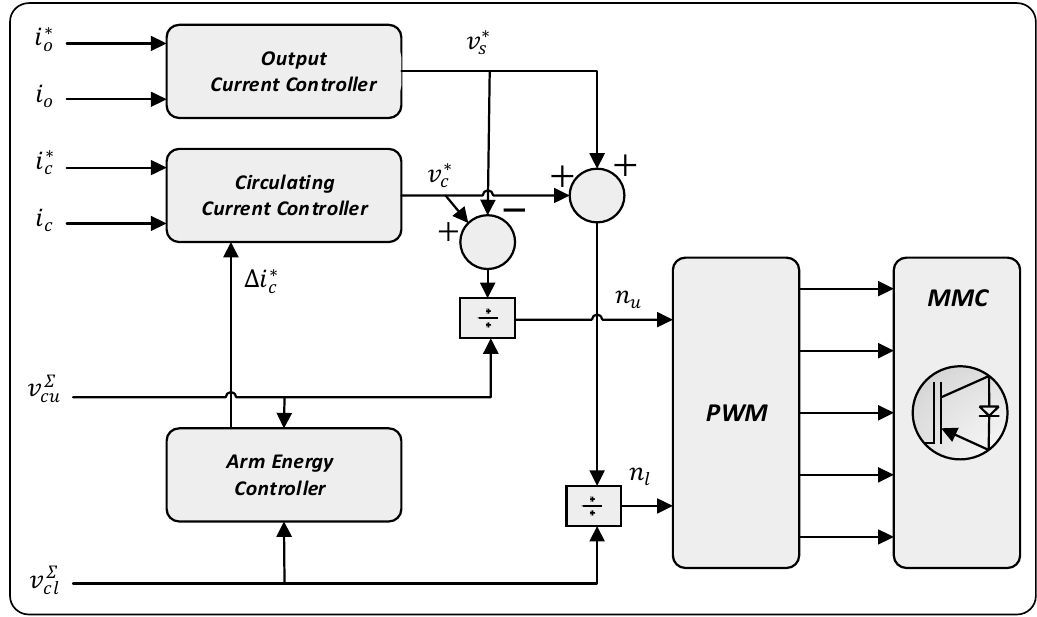
Figure 7 . Structure of MMC . Figure 7. Structure of